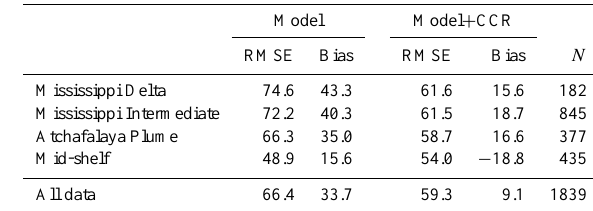
Table 1. RMSE and bias (both in units of mmolO 2 m − 3 ) between simulated and observed bottom DO concentrations. Comparisons were conducted over the simulation period from 2004 to 2007 us- ing all available observations. Bias was calculated as model minus observation. N is the number of observations available for each cat-